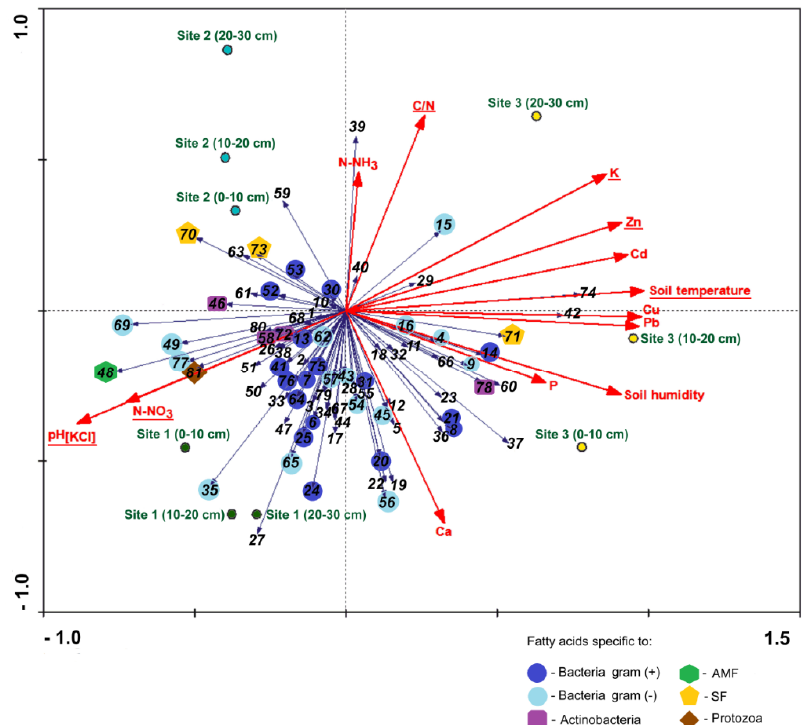
Figure 6. Redundancy Analysis (RDA) diagram of soil factors, whole cell fatty acids and study sites. Underlined factors contributed significantly to variance in whole cell fatty composition in soil (soil temperature. K. N-NO 3 . C / N. pH[KCl]. Zn) (Monte Carlo permutation test. p < 0.05). Study sites are marked by points. Whole-cell fatty acids are indicated by numbers: {1} 9:0; {2} unk 9.531; {3} 10:0; {4}